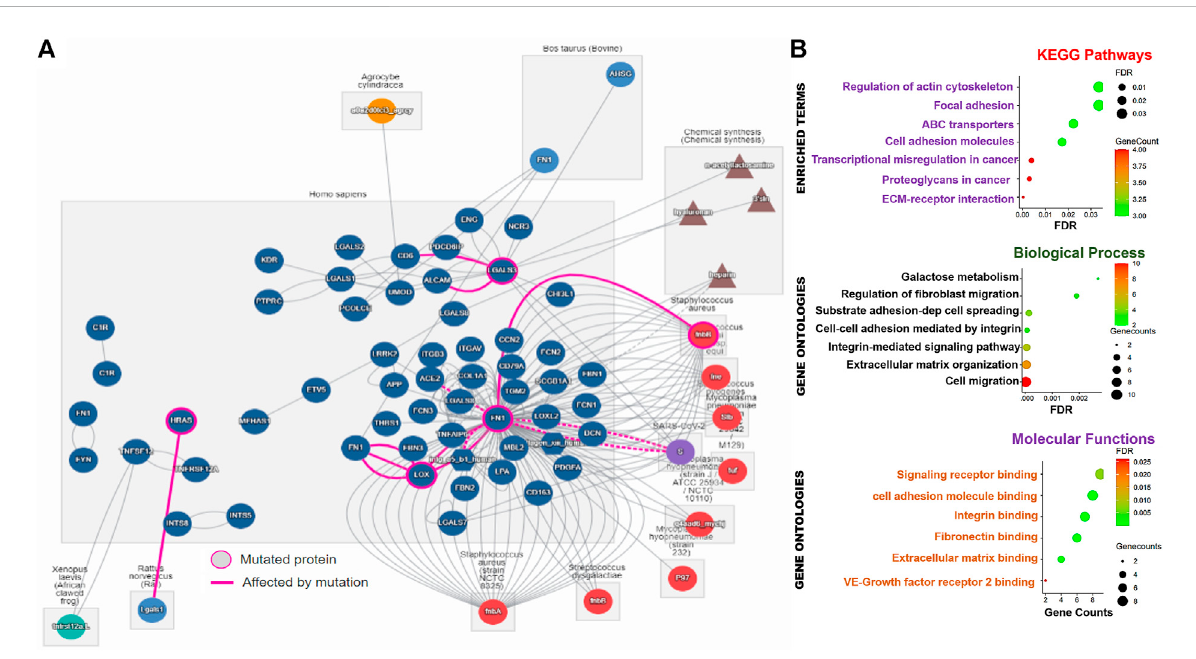
FIGURE 6 Thyroid tumor-enriched proteins (TTEPs) induced signi fi cant pathological interactions via cell-matrix adhesion and transcriptional dysregulation. (A) Network plots of direct protein – protein interactions of TTEPs. The direct protein – protein interaction was queried based on the human interaction of the proteins under the in fl uence of mutation or chemical treatment. (B) Enrichment network plots of KEGG pathways, GO molecular functions, and biological processes of the